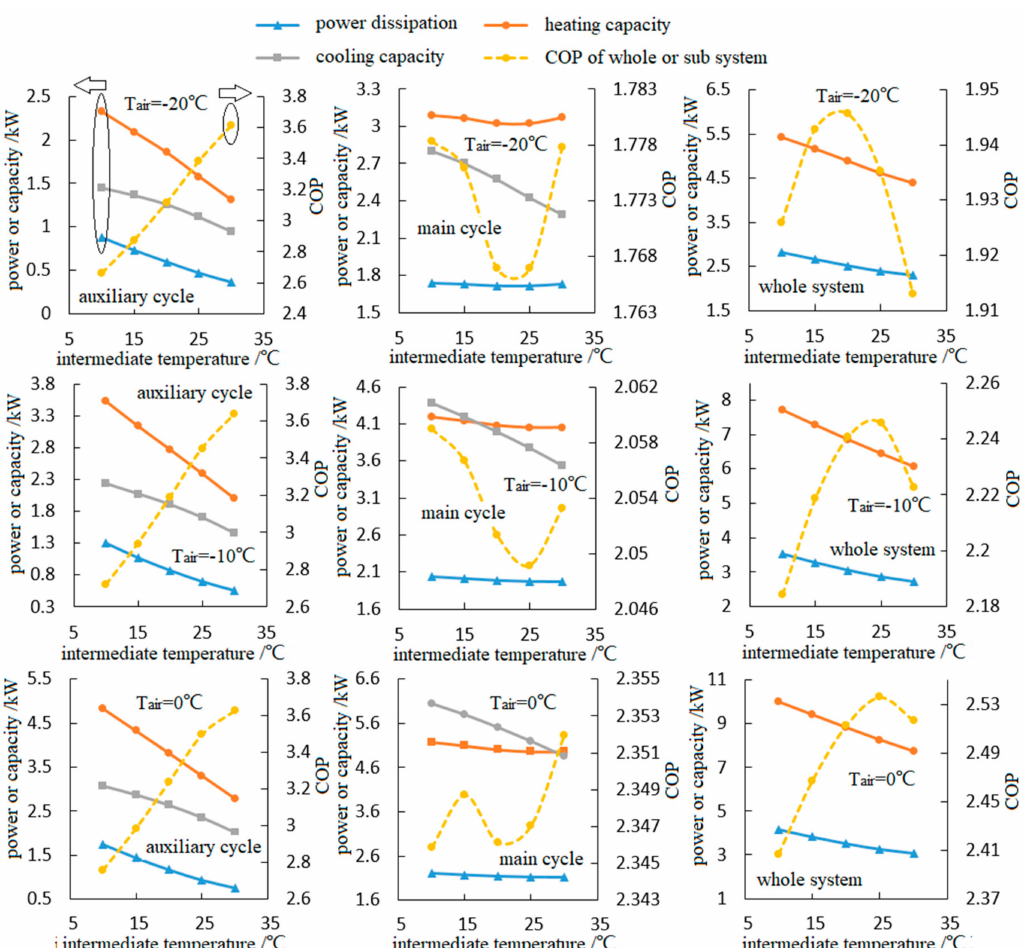
Figure 6. The thermodynamic parameters of the auxiliary cycle, main cycle and whole system under 50 ◦ C / 70 ◦ C in water-feed / supply